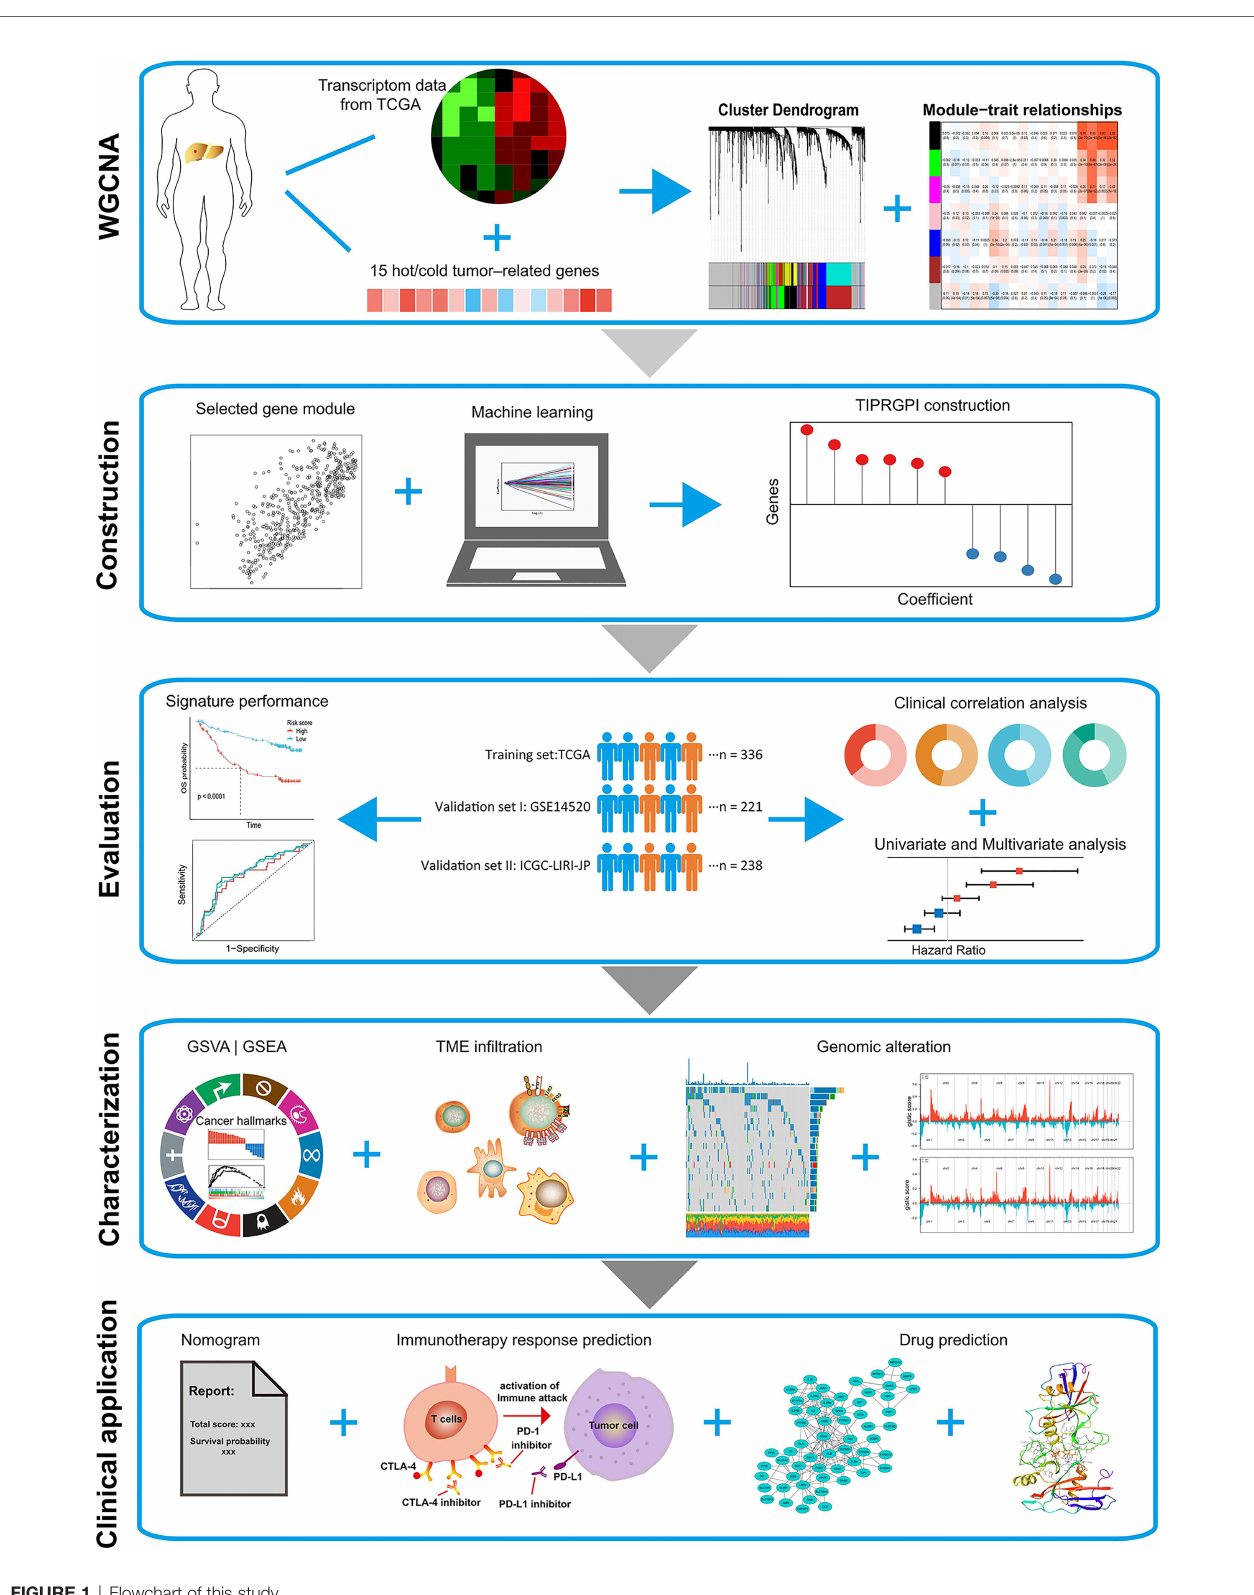
FIGURE 1 | Flowchart of this